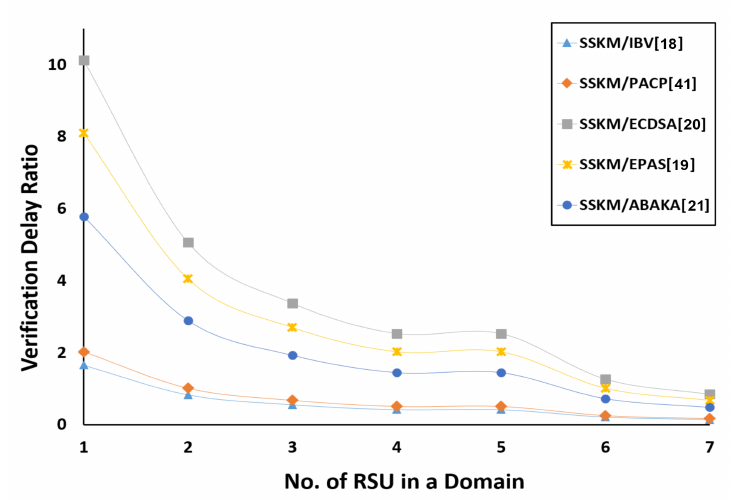
Figure 8. Verification delay ratio with multiple